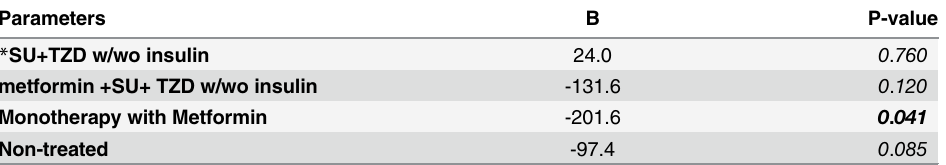
Table 7. Association of fasting serum levels of sCD26/DPP-IV with antidiabetes medications groups among type 2 diabetes